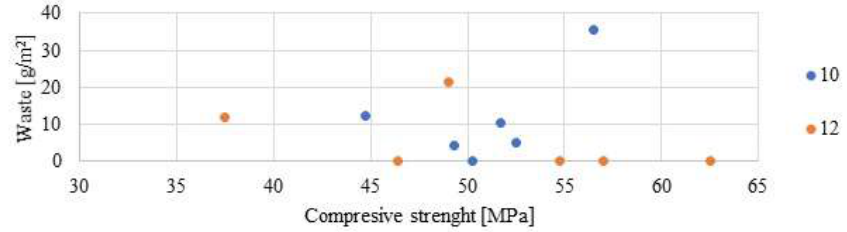
Figure 10. Dependence of the amount of waste after 125 cycles on the compressive strength.